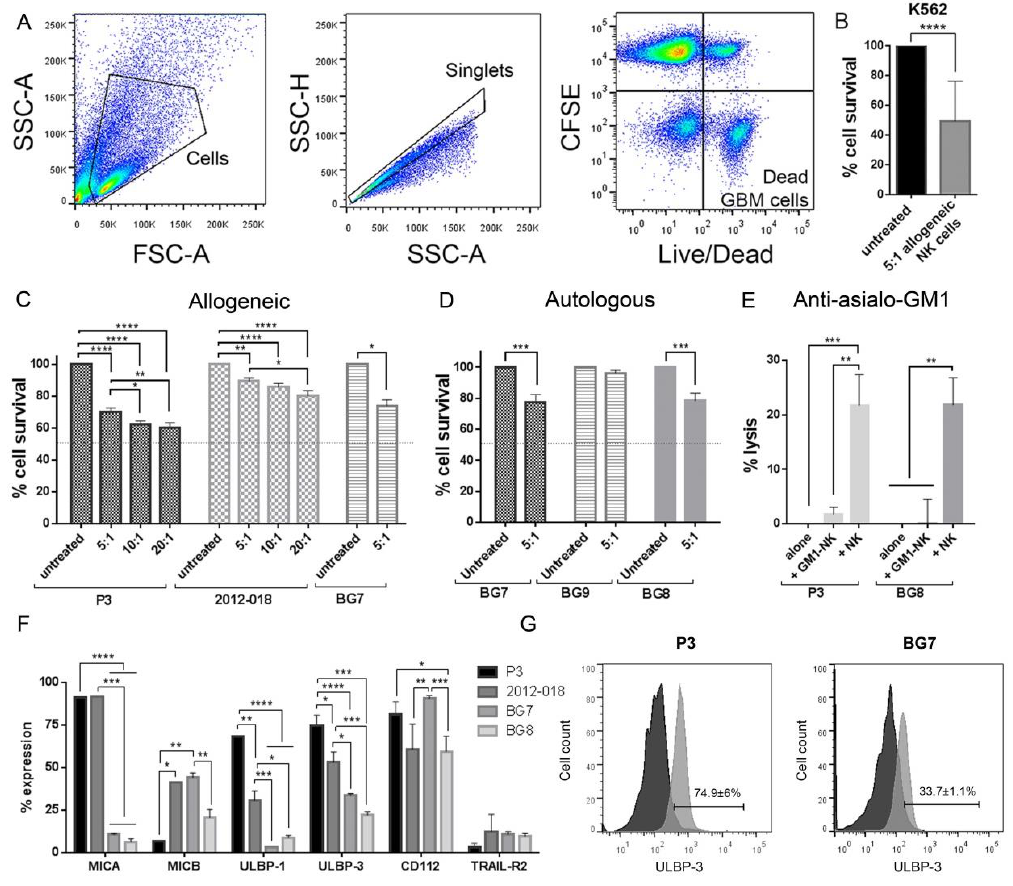
Figure 1. Figure 1. Cont.